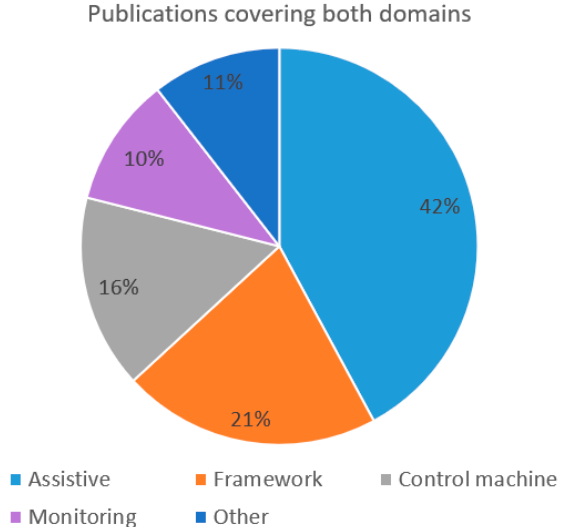
Figure 8. Distribution of publications covering both domains. The publications covering both domains have been focused mainly on assistive, but other fields such as framework and control machine also make up a significant proportion of the publications.